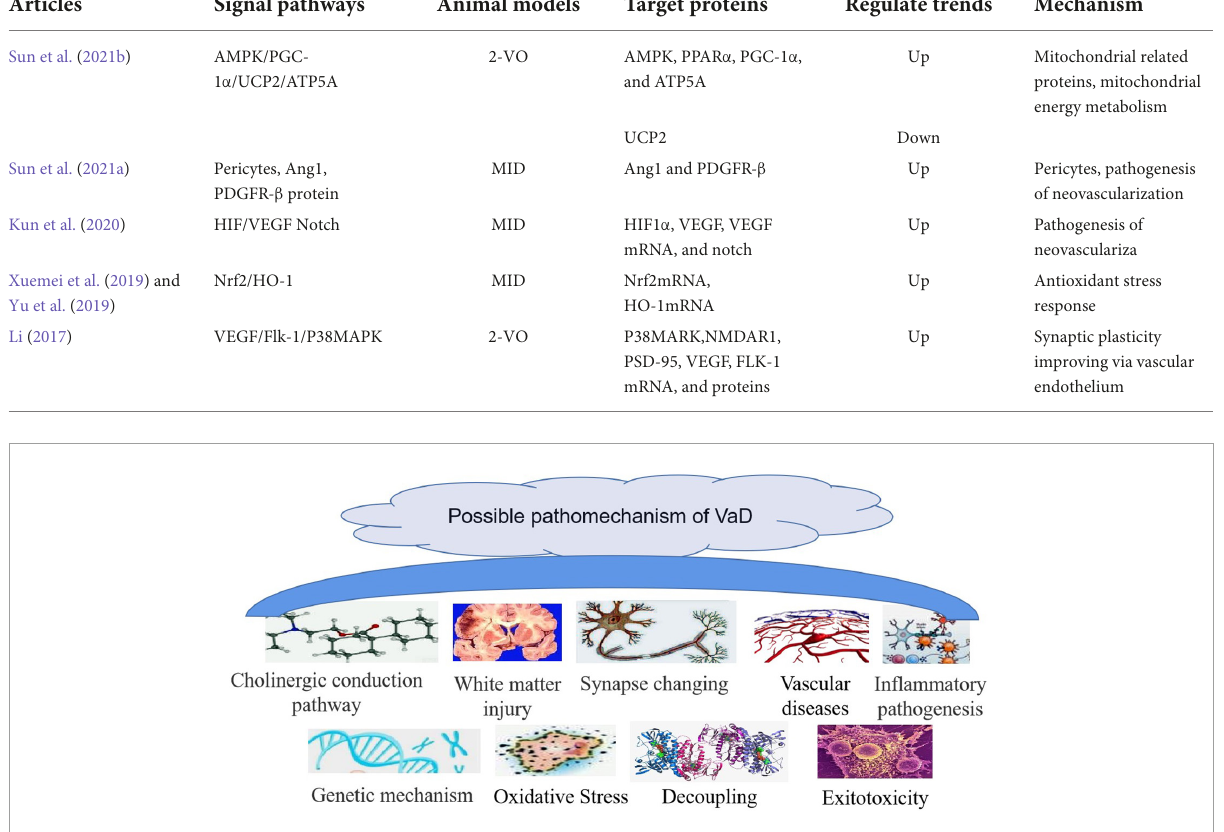
FIGURE6 Possible pathomechanism of vascular dementia (VaD). Sources for the images within this figure: 699pic.com and Chinese